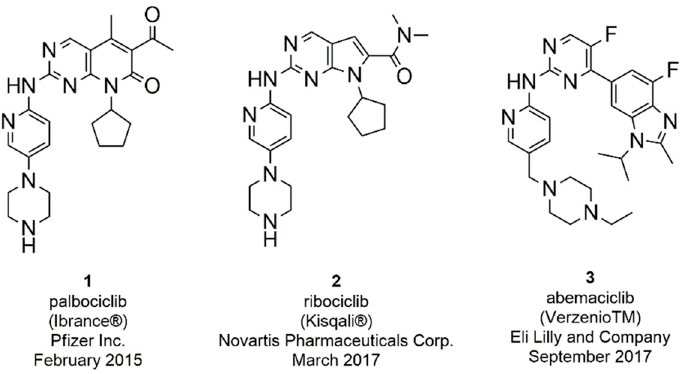
Figure 2. FDA approved CDK4/6 inhibitors palbociclib, ribociclib, and abemaciclib.